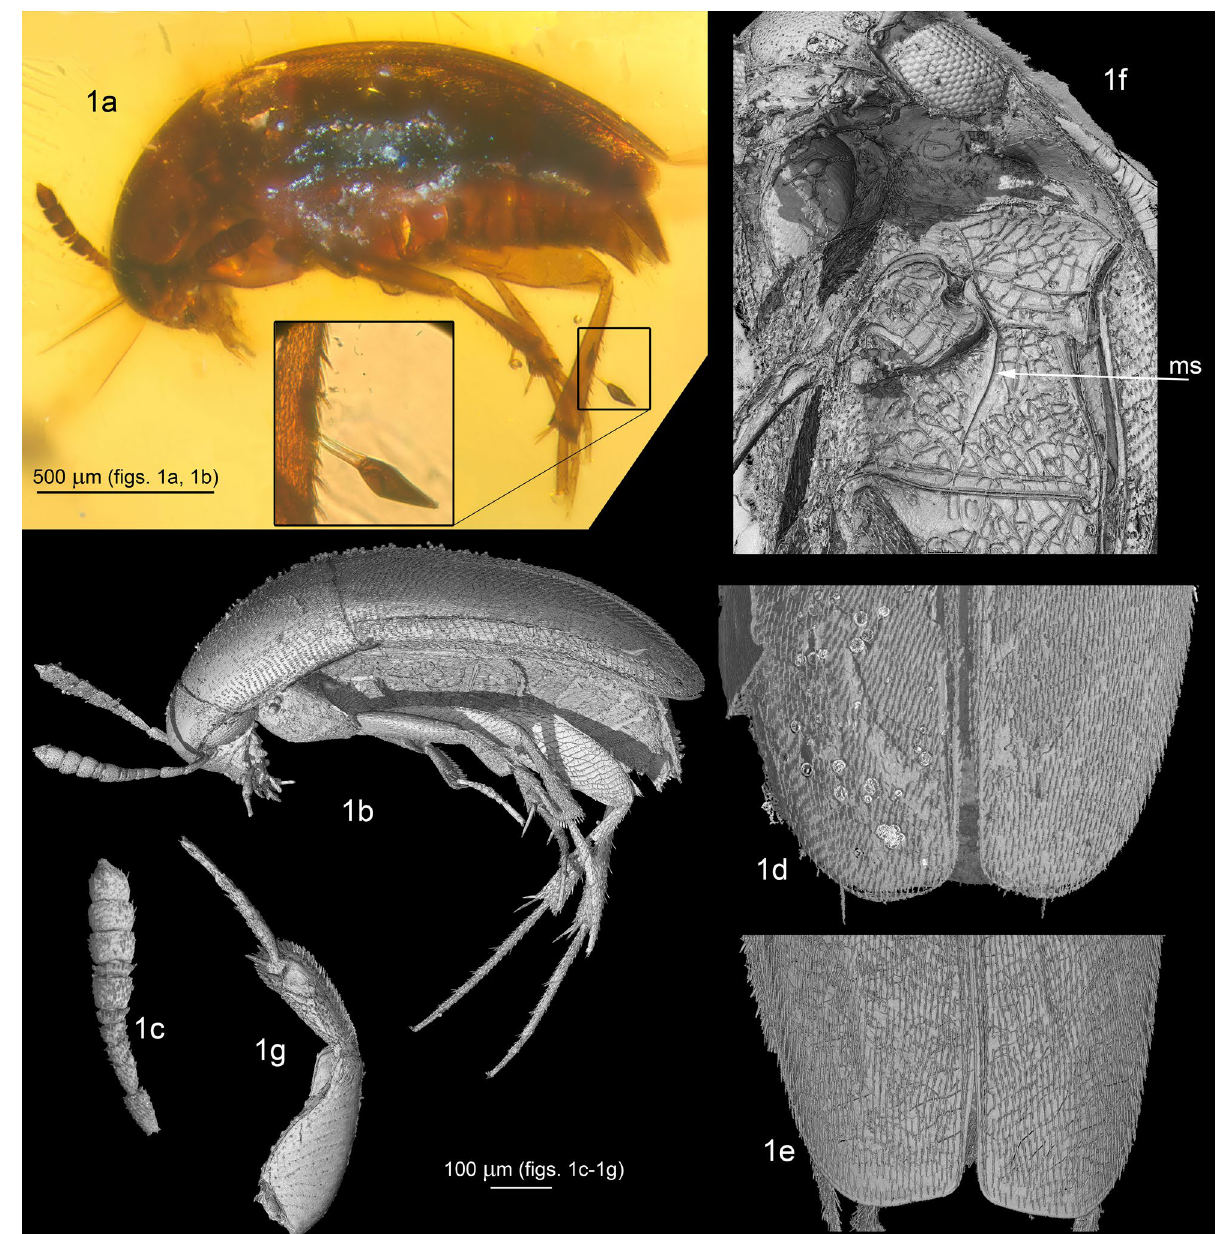
Figure 1. † Proptomaphaginus alleni sp. nov., external morphology. ( a ) paratype female, habitus lateral view with † Columnomyces electri . ( b ) holotype, lateral view (tomographic picture). ( c ) Antenna. ( d ) apex of elytra of female. ( e ) apex of elytra of male. ( f ) ventral structures. ( g ) foreleg. Abbreviation: ms = metaventral lateral